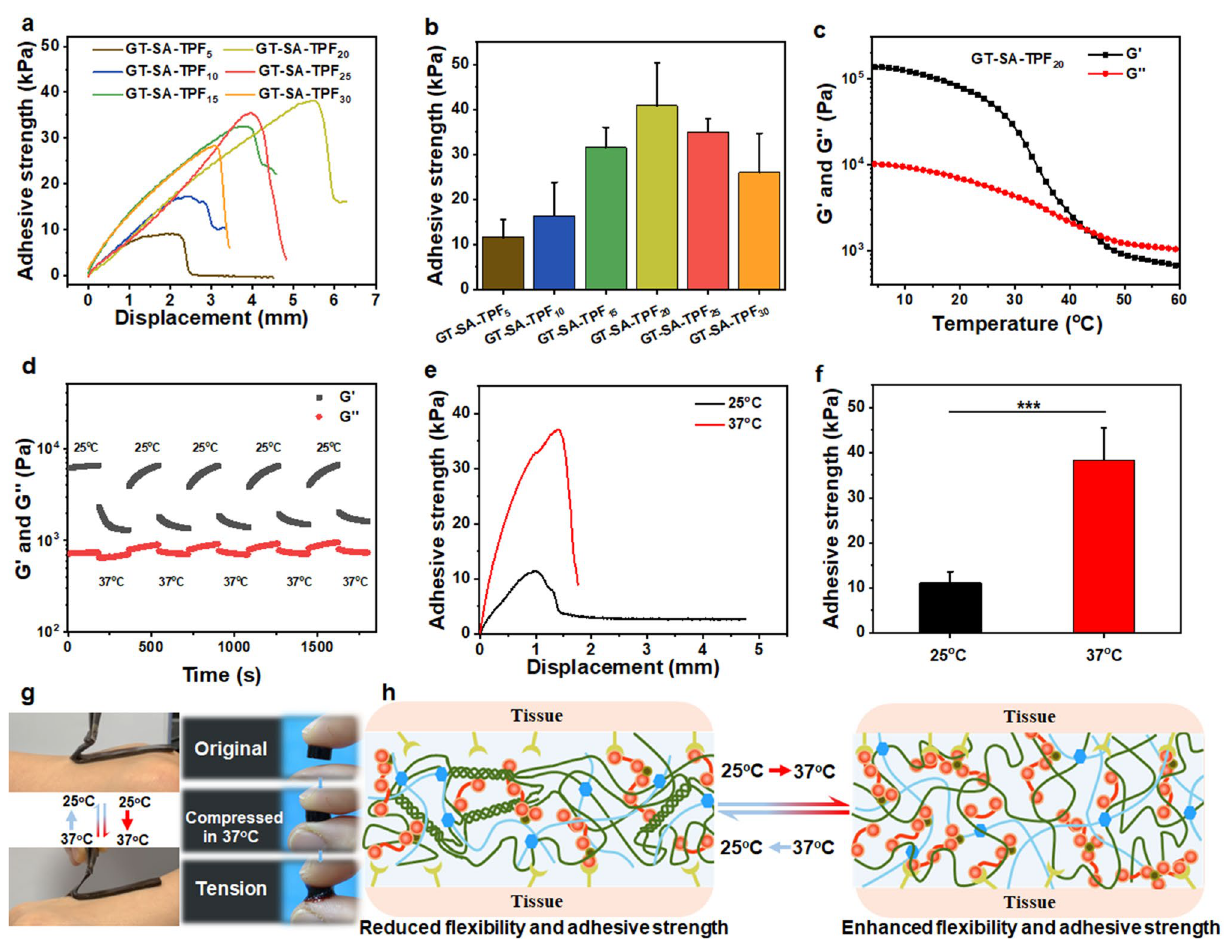
Fig. 5 Adhesive capacity and temperature responsive adhesion of the hydrogels on porcine skin tissues evaluated through lap-shear test. a Adhesive strength-displacement curves and b adhesive strength of different hydrogel samples on porcine skin tissue. c The temperature-depend- ent moduli of the hydrogel GT-SA-TPF 20 . d Time sweep of the hydrogel GT-SA-TPF 20 with temperature alternated from 25 to 37 °C for 5 cycles. e Adhesive strength-displacement curves and f adhesive strength of the hydrogel GT-SA-TPF 20 on porcine skin tissues at different tem- perature. g The presentation of temperature-dependent adhesion on human skin tissues. h Illustration of the proposed temperature-dependent adhesion mechanism. *** p <